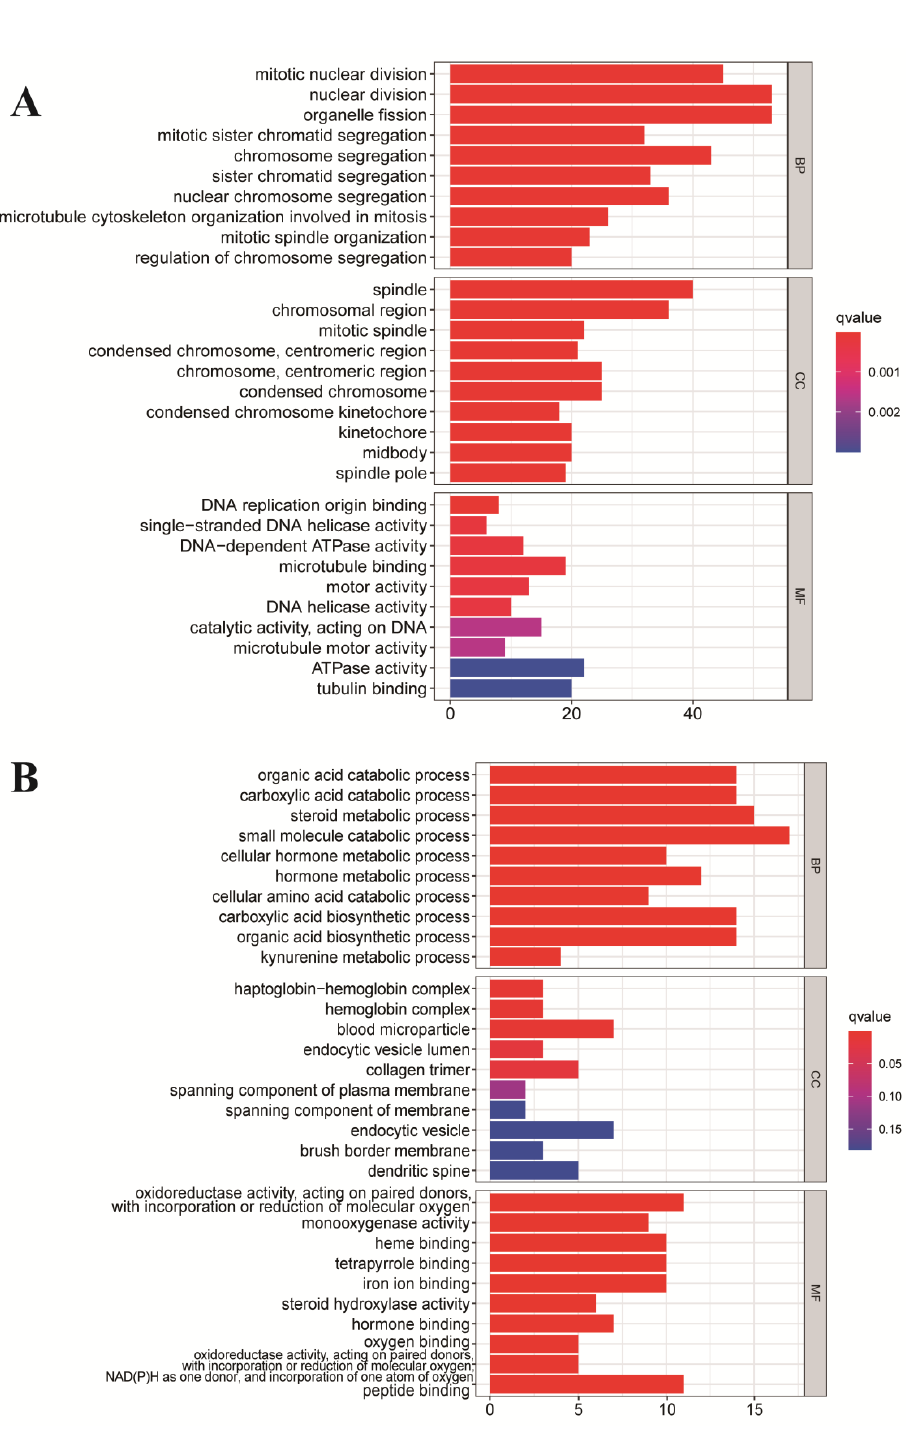
Figure 3. GO functional annotation for the DE mRNAs. ( A ) Upregulated DE mRNAs. ( B ) Downreg- ulated DE mRNAs.